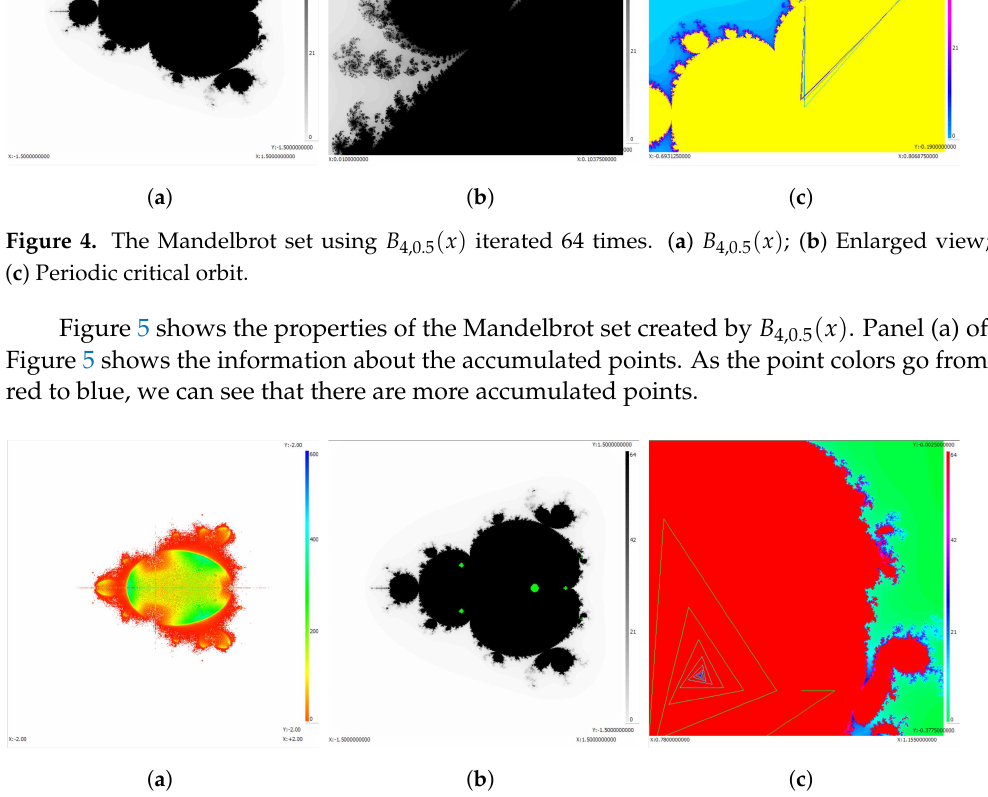
Figure 5. Special features of the Mandelbrot set using B 4,0.5 ( x ) . ( a ) Accumulated map; ( b ) Fixed points; ( c ) Attracting fixed